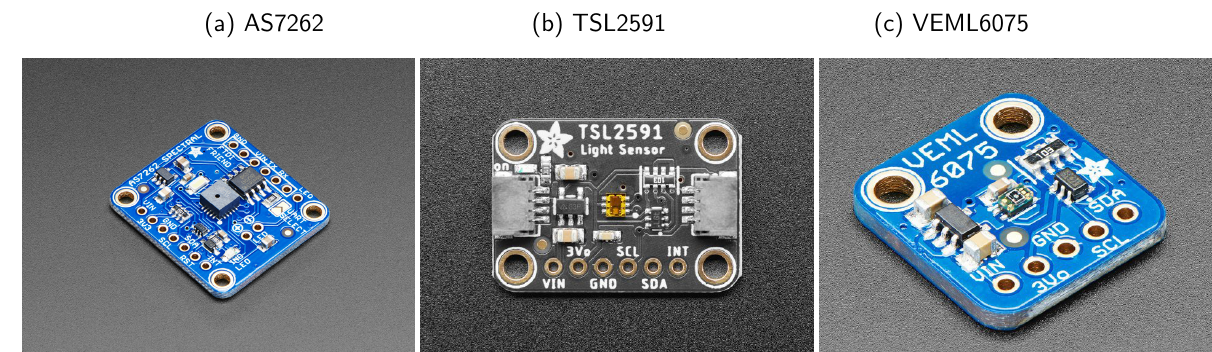
Figure 4. Low-cost light sensors: TSL2591, VEML6075 and AS7262 sold by the open-source hardware company, Adafruit